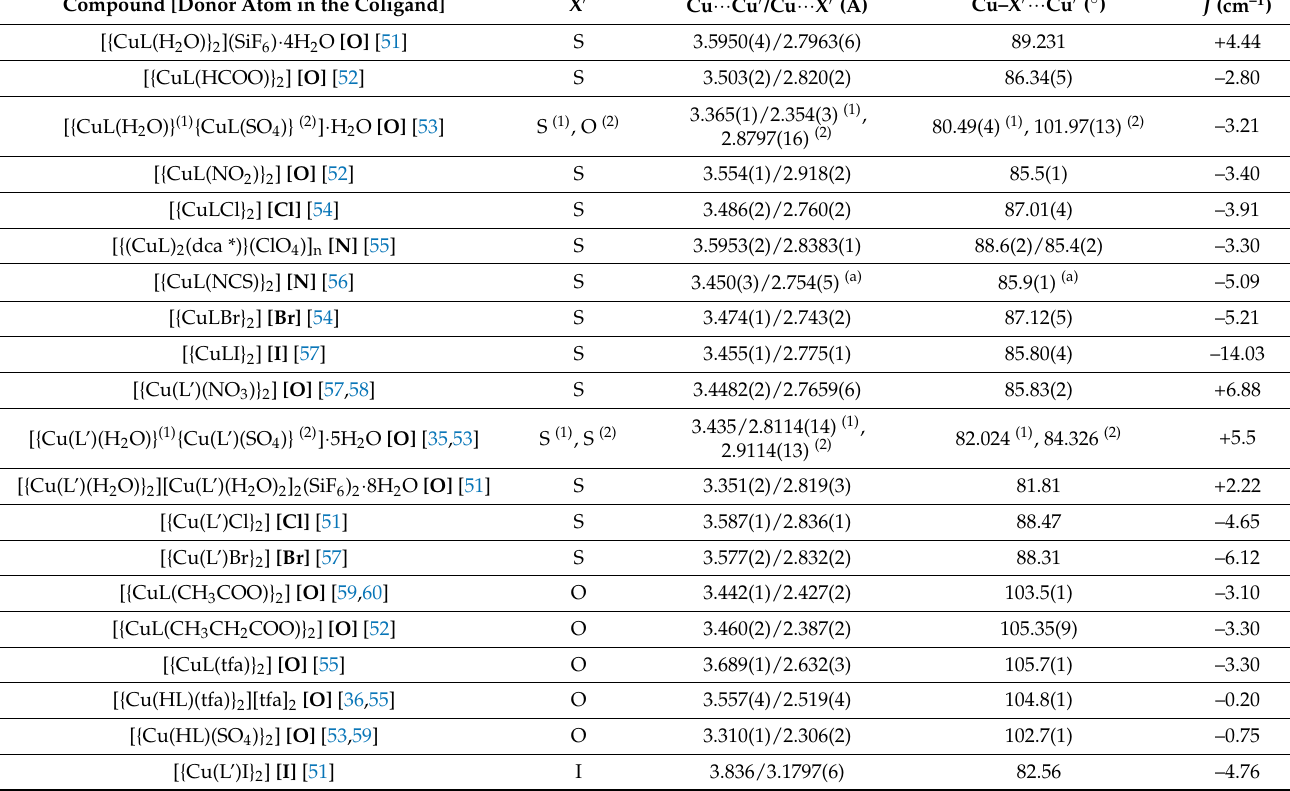
Table 1. J values (defined from a H = − 2 JS 1 S 2 Hamiltonian) along with some crystallographic pa- rameters, for both S- and X-bridge dimer [{Cu(L/L’)X} 2 ] systems. The first column specifies the donor atom [X] (see X in bold, in Scheme 4). The intradimeric distances are represented as Cu ··· Cu’ (Å); X’ is the apical ligand, linkages to the apical ligand are depicted as Cu ··· X’ (Å), and bridging angles as Cu–X (cid:48) ··· Cu (cid:48) ( ◦